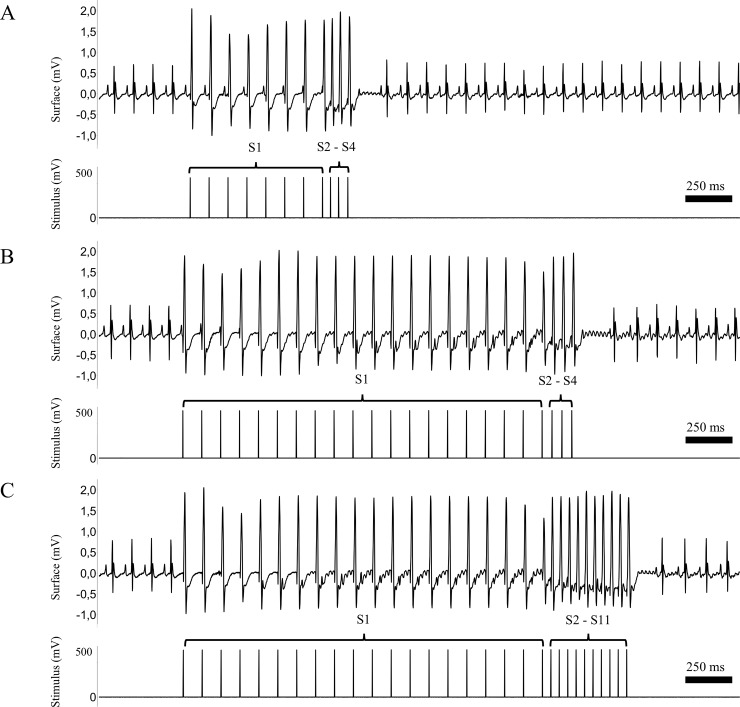
Examples of conventional and modified protocols to investigate the inducibility of ventricular arrhythmias by programmed electrical stimulation.A: Conventional programmed electrical stimulation (PES) protocol, which consists of eight S1 stimuli followed by two (S3) to three (S4) extrastimuli that are coupled in decrements of 2ms intervals from 60ms to 20ms. B: A representative example of the modified extrastimulation protocol depicts twenty S1 stimuli followed by three (S2-S4) extrastimuli. This protocol was defined as “miniburst (MB)”. C: The miniburst protocol with ten (S2-S11) extrastimuli. (for details see text).